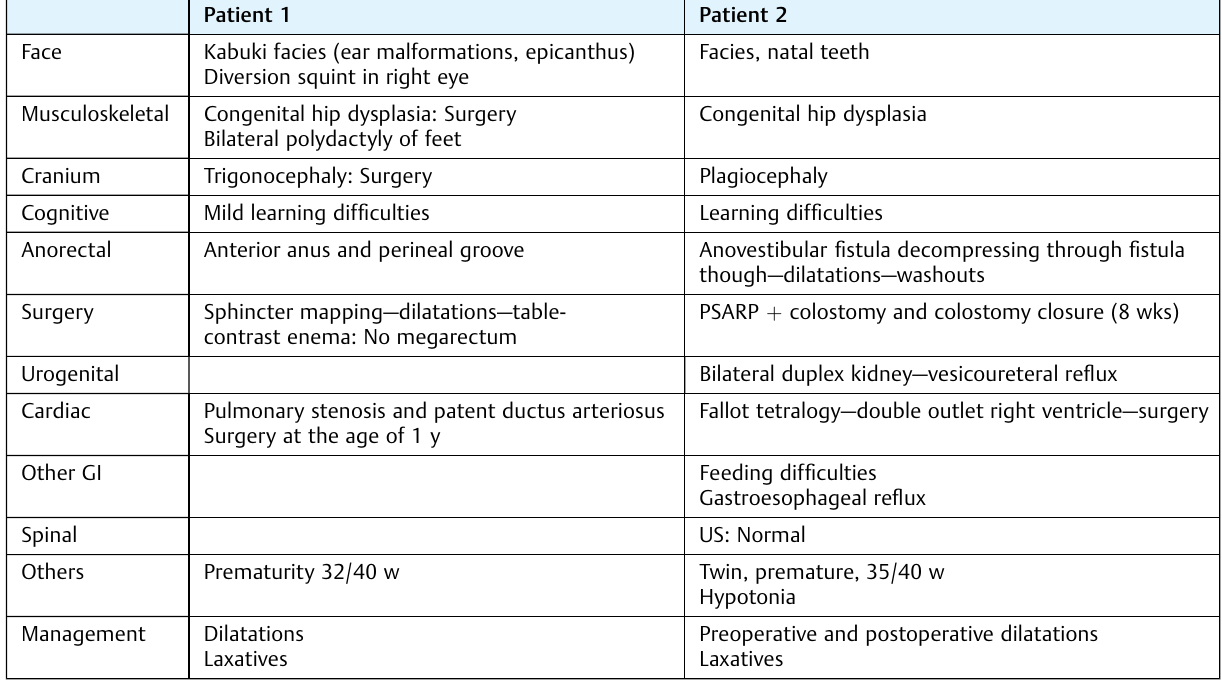
Table 1 Constellation of anomalies in the reported